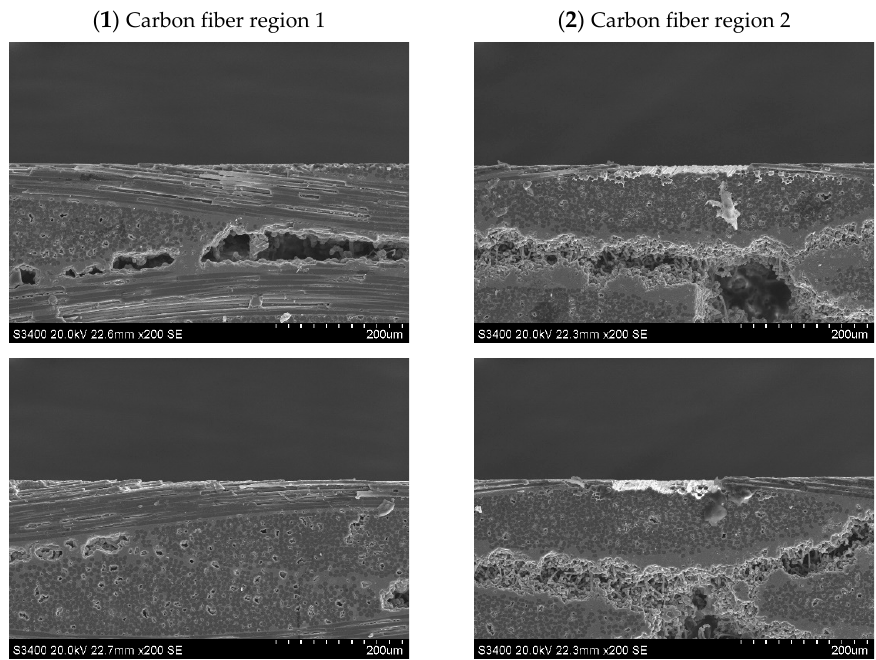
Figure 22. Subsurface morphologies of typical the C/SiC composite material after common grinding and ultrasonic vibration-assisted grinding(v s = 1.26 m/s, v w = 100 mm/min, a p = 0.1 mm).